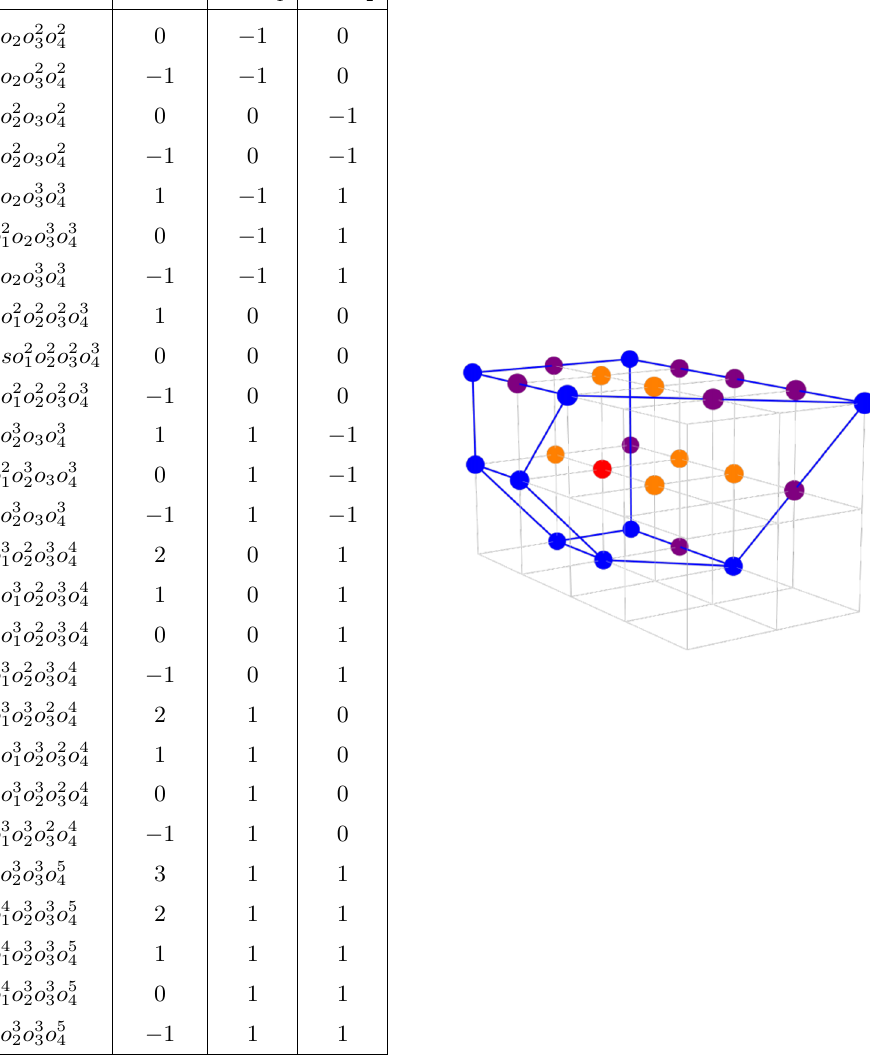
Table 60 . The generators and lattice of generators of the mesonic moduli space of Model 15 in terms of brick matchings with the corresponding flavor